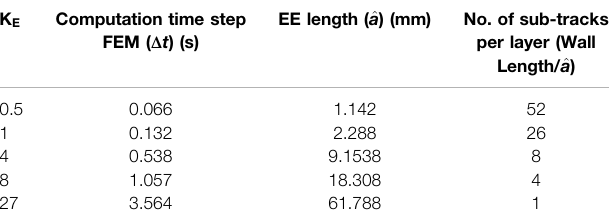
TABLE 7 | Elongated Ellipsoid (EE) heat source parameters used in the present work.